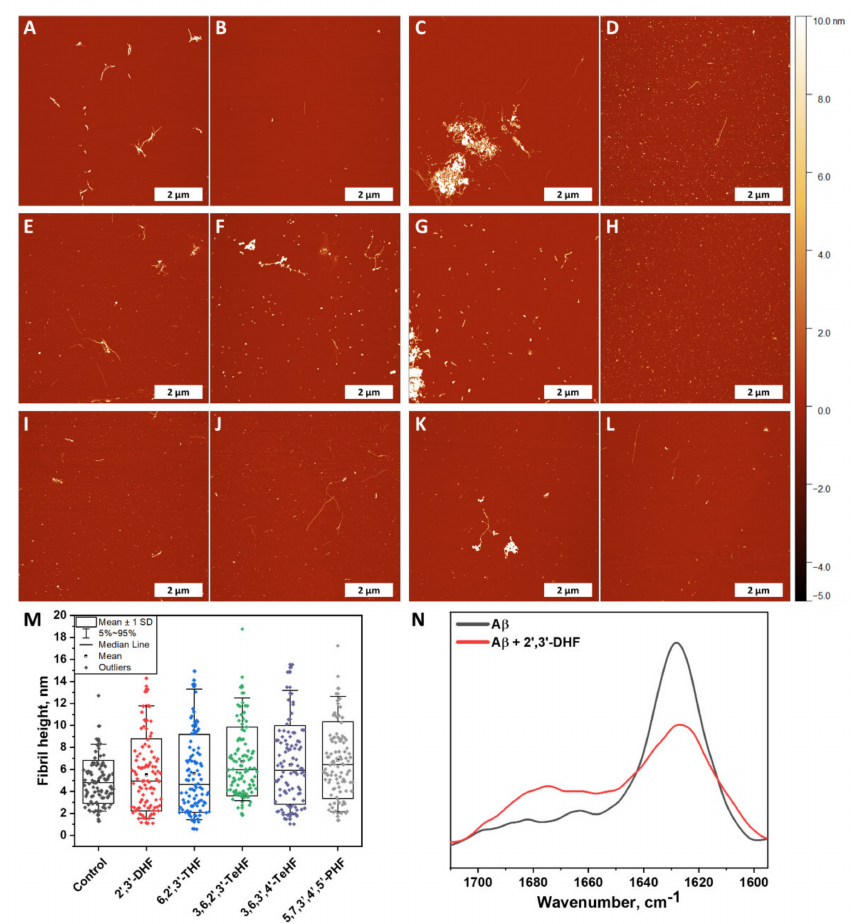
Figure 5. Atomic force microscopy images of A β 42 formed without ( A , B ) and with 50 µ M of oxidized 2 (cid:48) ,3 (cid:48) -DHF ( C , D ), 6,2 (cid:48) ,3 (cid:48) -THF ( E , F ), 3,6,2 (cid:48) ,3 (cid:48) -TeHF ( G , H ), 3,6,3 (cid:48) ,4 (cid:48) -TeHF ( I , J ) and 5,7,3 (cid:48) ,4 (cid:48) ,5 (cid:48) -PHF ( K , L ) flavones. Fibril and oligomeric species height distribution ( M ), where box plots indicate mean ± SD and error bars are in the 5%–95% range ( n = 100). FTIR spectra ( N ) of A β 42 fibrils formed alone and with 50 µ M of 2 (cid:48) ,3 (cid:48) -DHF. The AFM images of A β 42 aggregates formed with all inhibitors showed a similar distribution in height and revealed round shape structures that were not present in the image of the control sample. The FTIR spectrum of the sample with 2 (cid:48) ,3 (cid:48) -DHF had less expressed β -sheet-related band at 1629 cm − 1 than the control